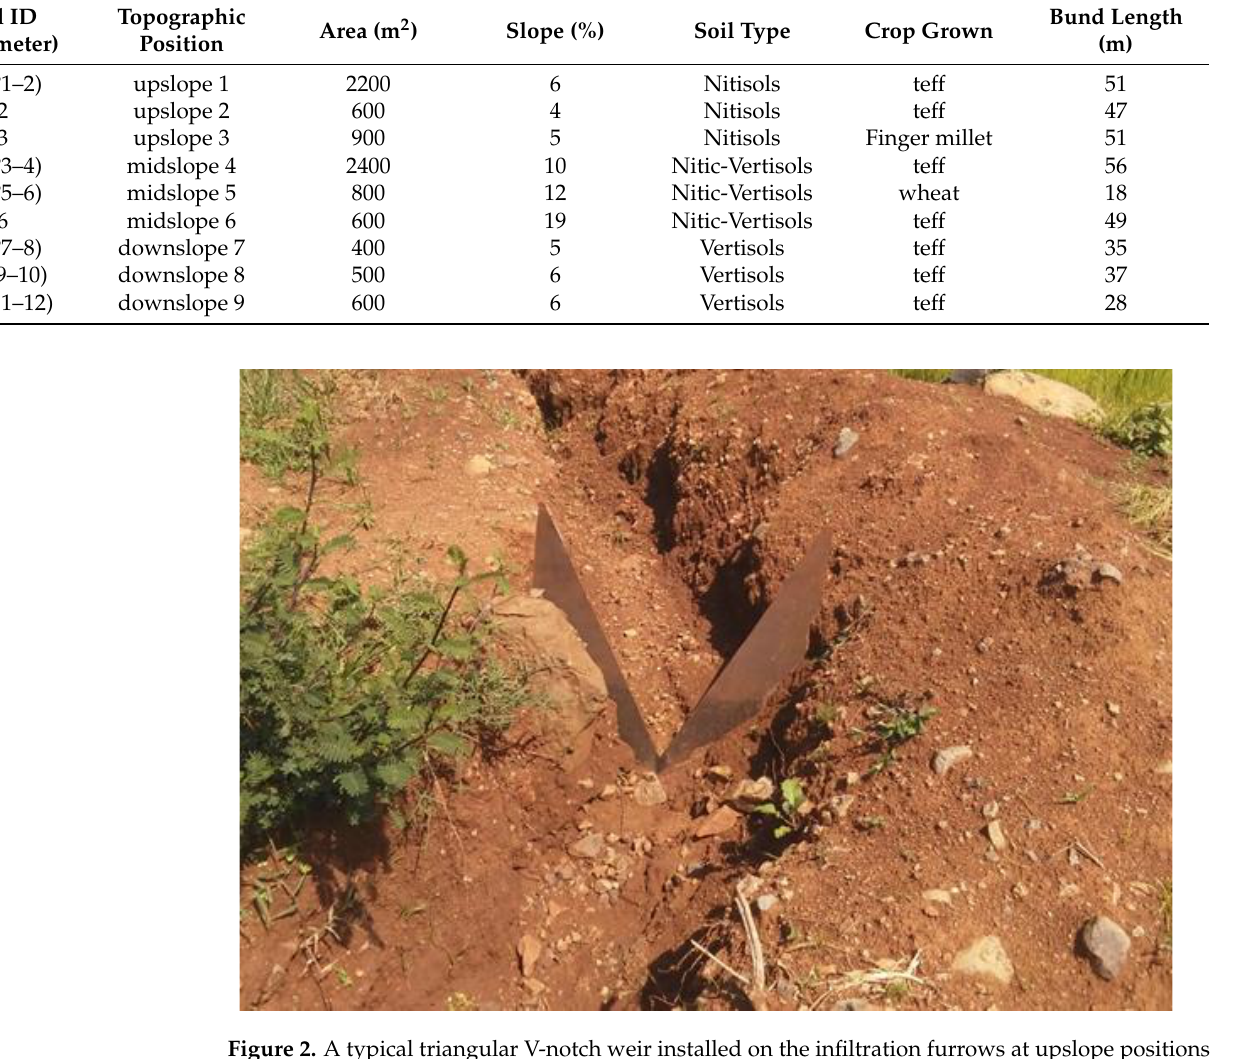
Table 1. Attributes of experimental fields in the Debre Mawi watershed. P1–P12 piezometers installed to measure water table depth at several V-notch weirs.